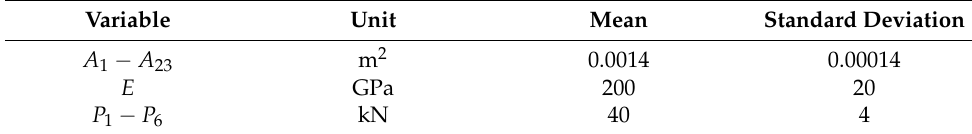
Table 8. Basic random variables in Example 4.